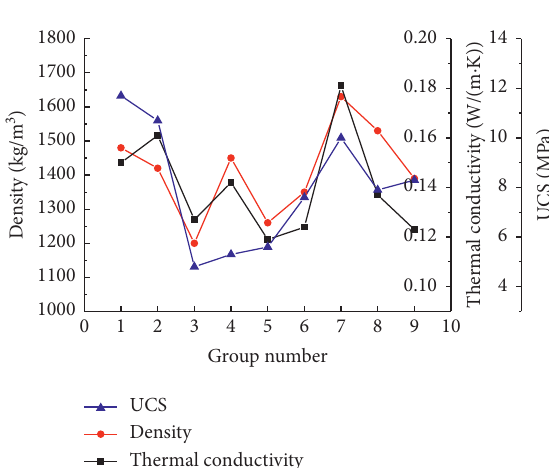
Figure 3: Physical and mechanical properties data of compounded samples.